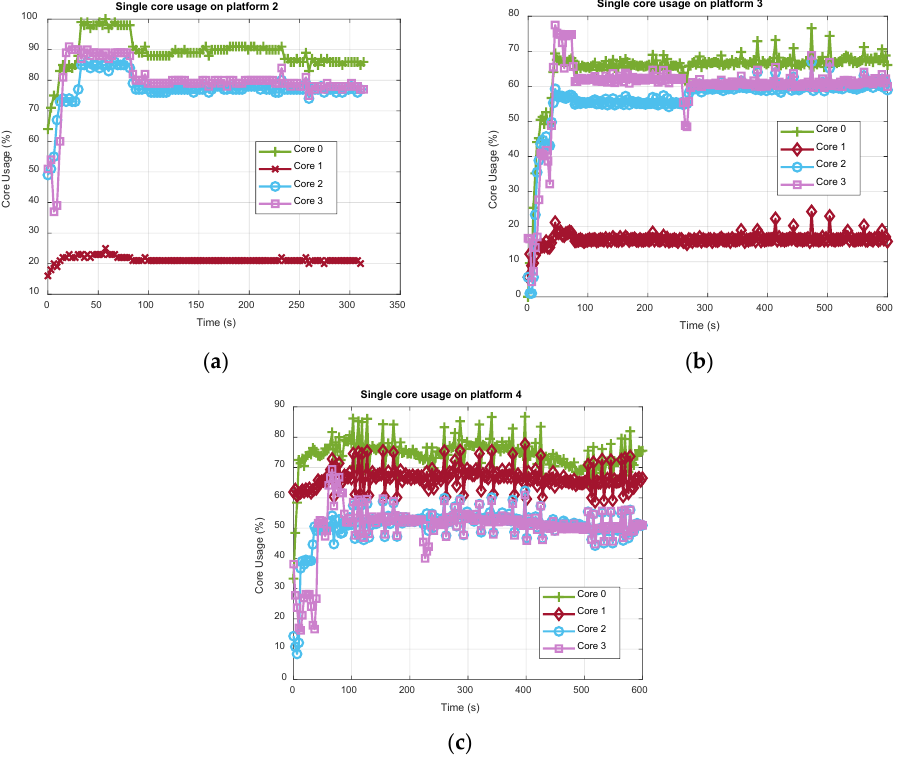
Figure 9. Time evolution of the cores’ usage of eNGene receiver on ODROID-X2 ( a ), Raspberry Pi4 ( b ) and ODROID-C4 ( c ) platforms for 12 satellites, i.e., 6 GPS and 6 Galileo, simultaneously tracked.